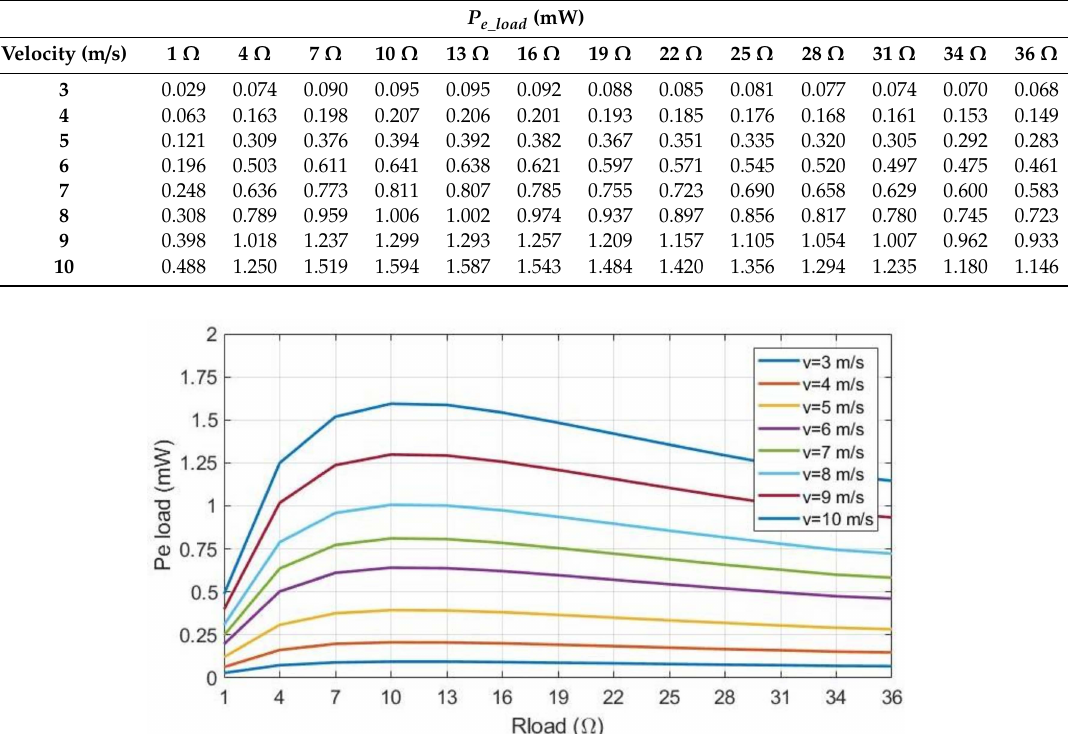
Table 6. Calculated harvester power values for di ff erent loads and air velocities.